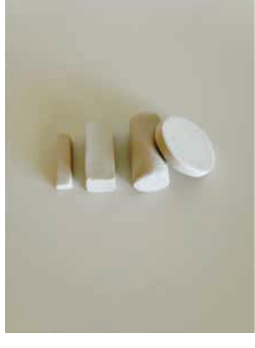
Figure 2b: Example of picture stimuli. Figure 2a: Set of object